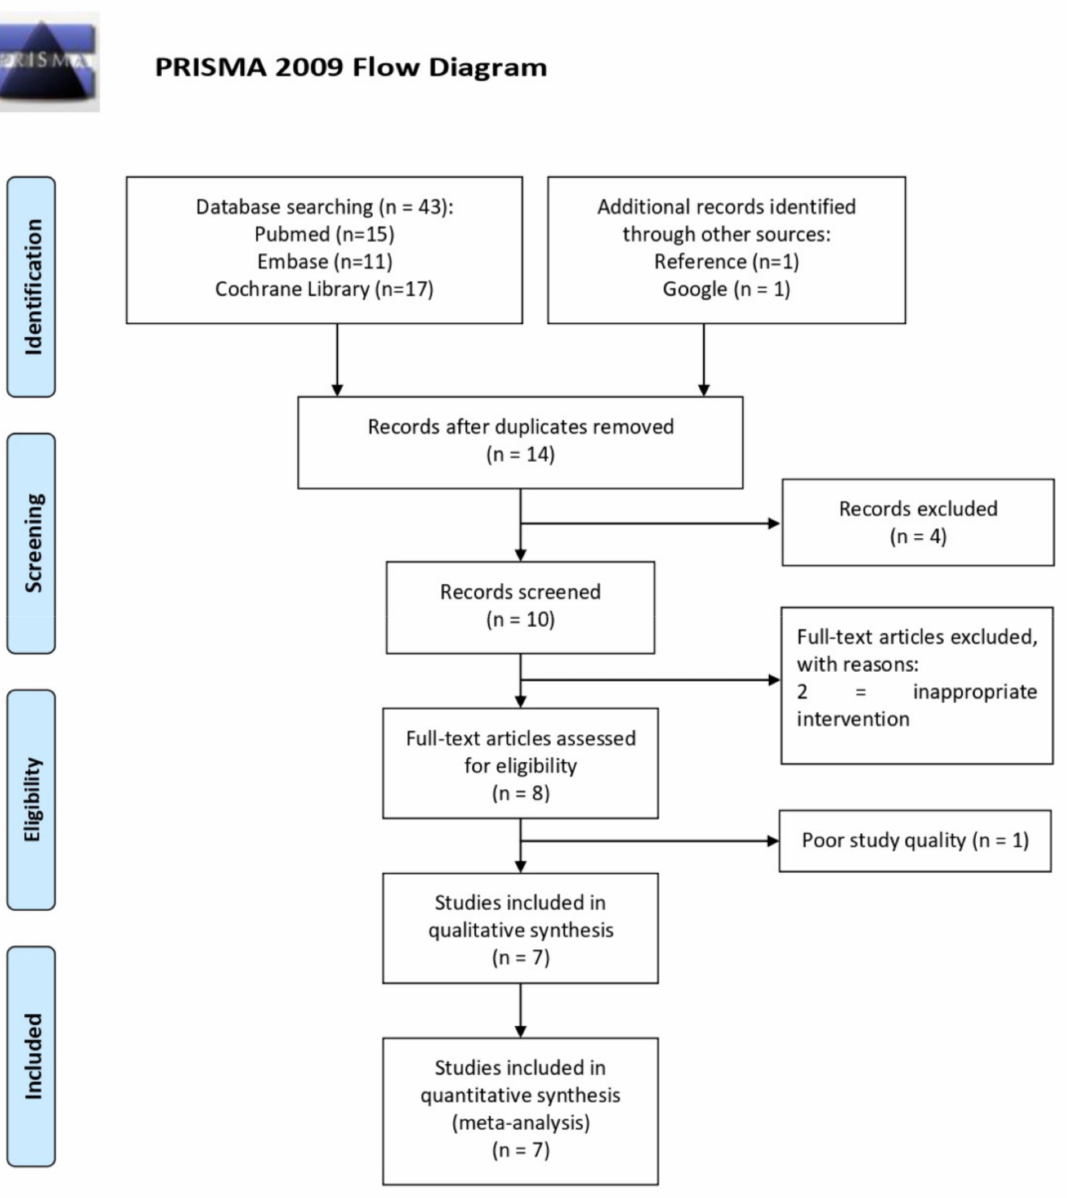
Figure 1. After titles/abstracts were screened, the eligibility of 10 full-text articles was